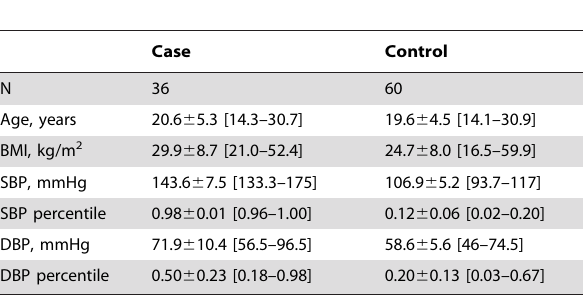
Table 3. General characteristics of the subjects in GA cohort (1 st replication panel).